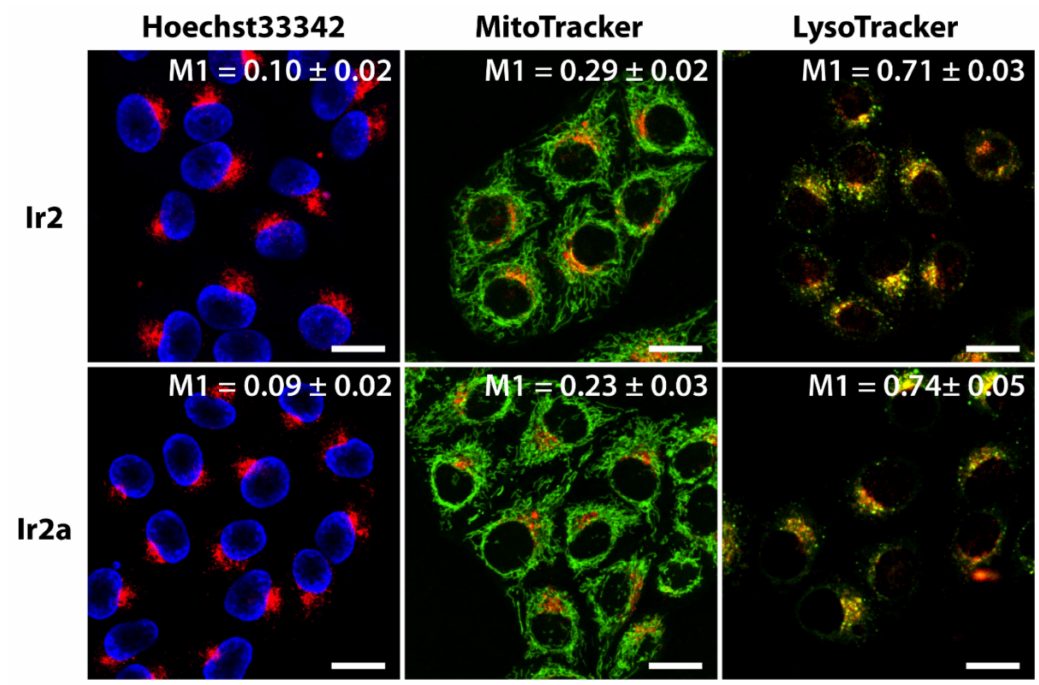
Figure 7. Subcellular distribution of complexes Ir2 and Ir2a (75 µ M) in HeLa cells (red color of luminescence). Cells were co-stained with complexes and organelle-specific probes for nuclei-Hoechst 33342 (blue color of luminescence), mitochondria- MitoTracker Green (green color of luminescence), and lysosomes-LysoTracker Green (green color of luminescence). Scale bar 20 µ m. Manders’ overlap coefficients (M1) shown in the pictures are presented as mean + standard deviation, calculated for 50 cells for every